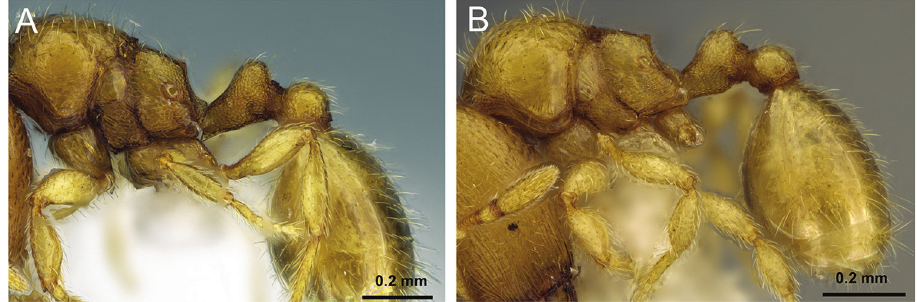
Figure 11. Petiole and postpetiole in profile view of A Carebara berivelo (CASENT0438188) B Care- bara tana